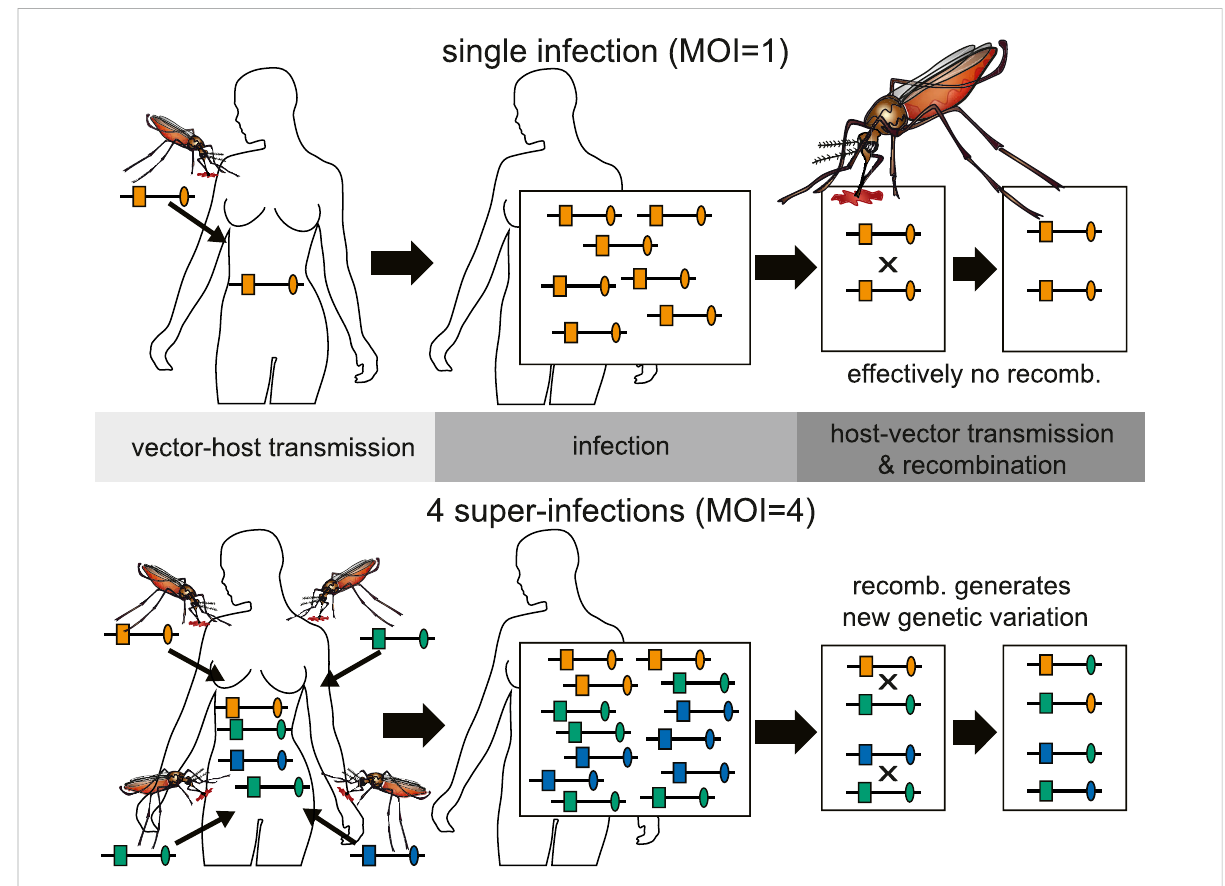
IllustrationoftherelationshipbetweeninbreedingandMOI.Top:AninfectionwithMOI=1(single-cloneinfection)leadsonlytorecombination between clones, i.e., effectively to no recombination. Bottom: Shown is a super-infection with four infective events (MOI = 4) and three different haplotypes being transmitted (one haplotype is transmitted independently by two mosquitoes). Recombination between the illustrated haplotypes leads to the creation of new